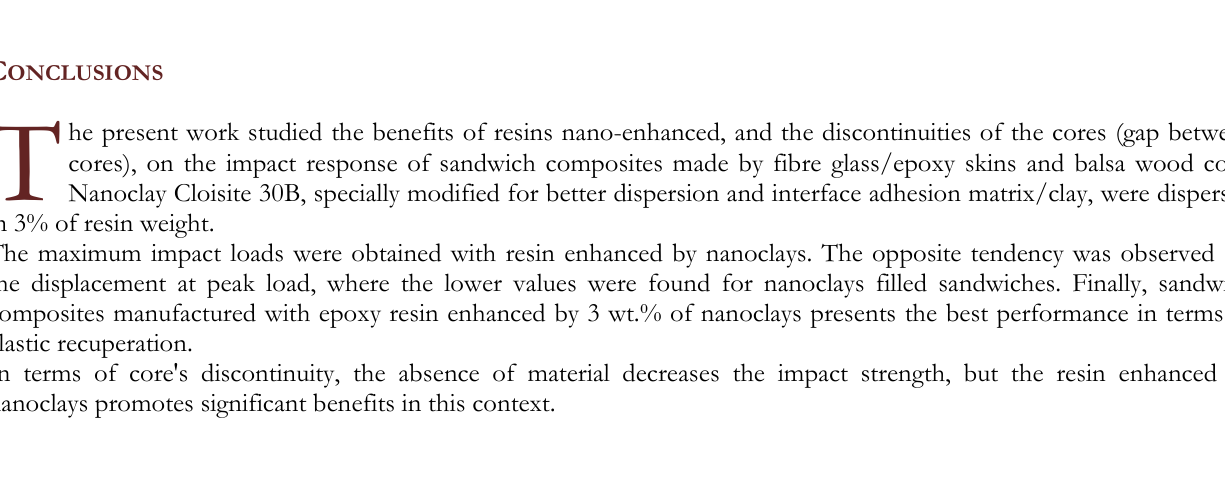
Table 1: Effect of the gap on the different impact